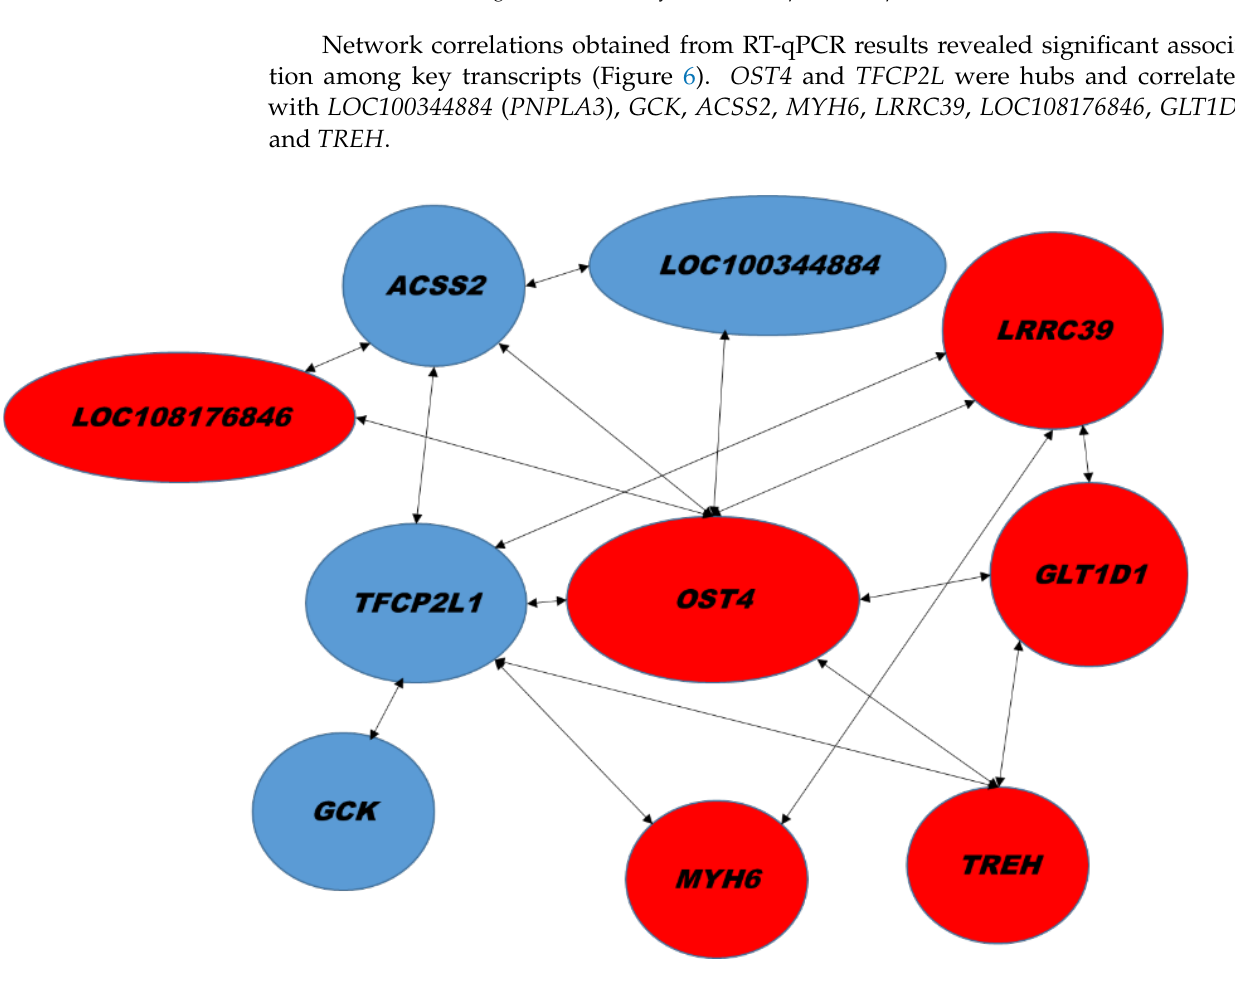
Figure 5. Concordance between used methods of RNA analysis. (A) Correlation analysis of 17 se- lected genes between RNAseq and RT-qPCR normalized to the invariant PIPB and GAPDH genes. The mean values obtained for signal log 2 ratio (SL 2 R) from individual analyses (Table 3) were plot- ted against the RNAseq which used partially pooled samples (Tables 1 and 2). Good agreement between the procedures was observed (r = 0.8, p < 0.0001). ( B ) Difference in results of SL 2 R expression of both procedures of the 17 selected genes.